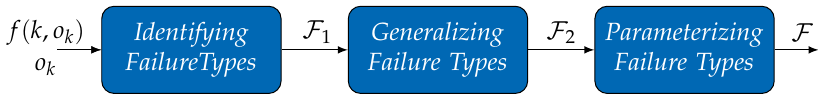
Figure 7. Processing chain for automated failure model